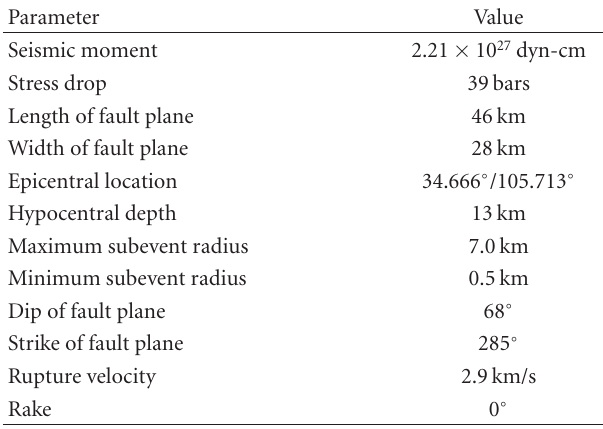
Table 3: Source parameters for scenario B.